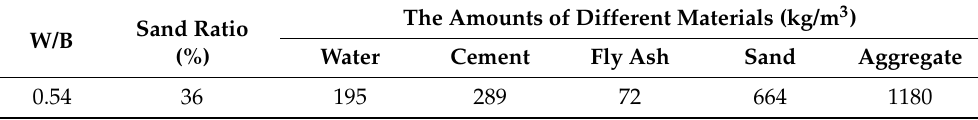
Table 2. Designed mixture for concrete by